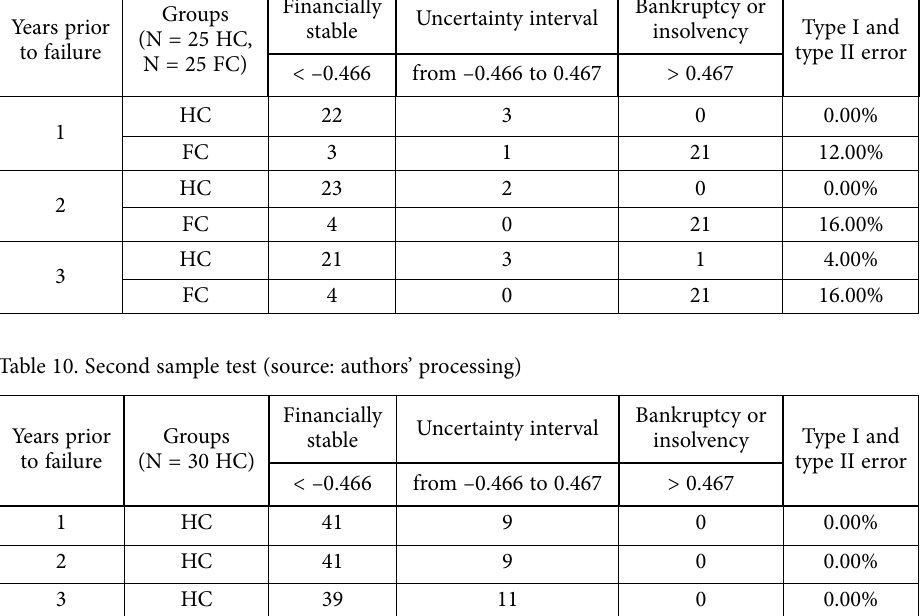
Table 9. First sample test (source: authors’ processing) Years prior to failure